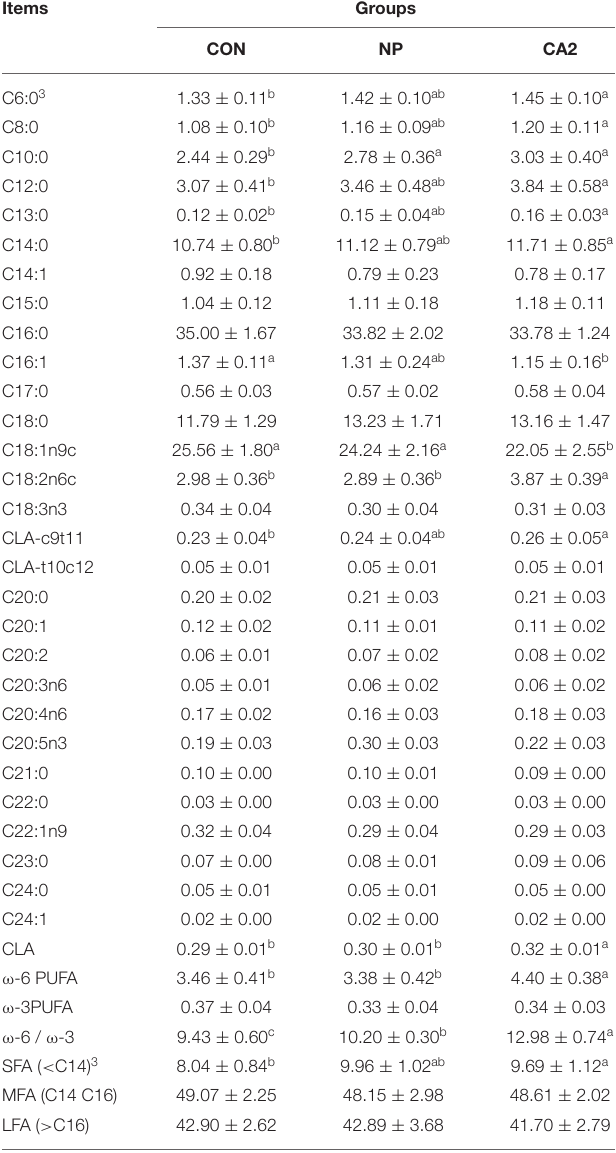
TABLE 7 | Effects of processed WCS on milk fatty acid composition (%). Items Groups